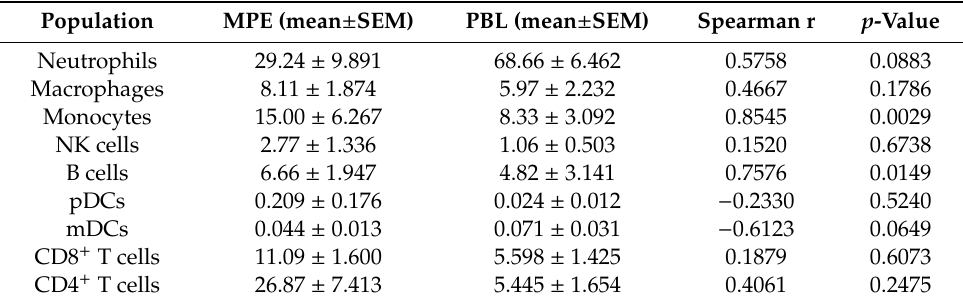
Table 2. MPE / PBL Correlations of Immune